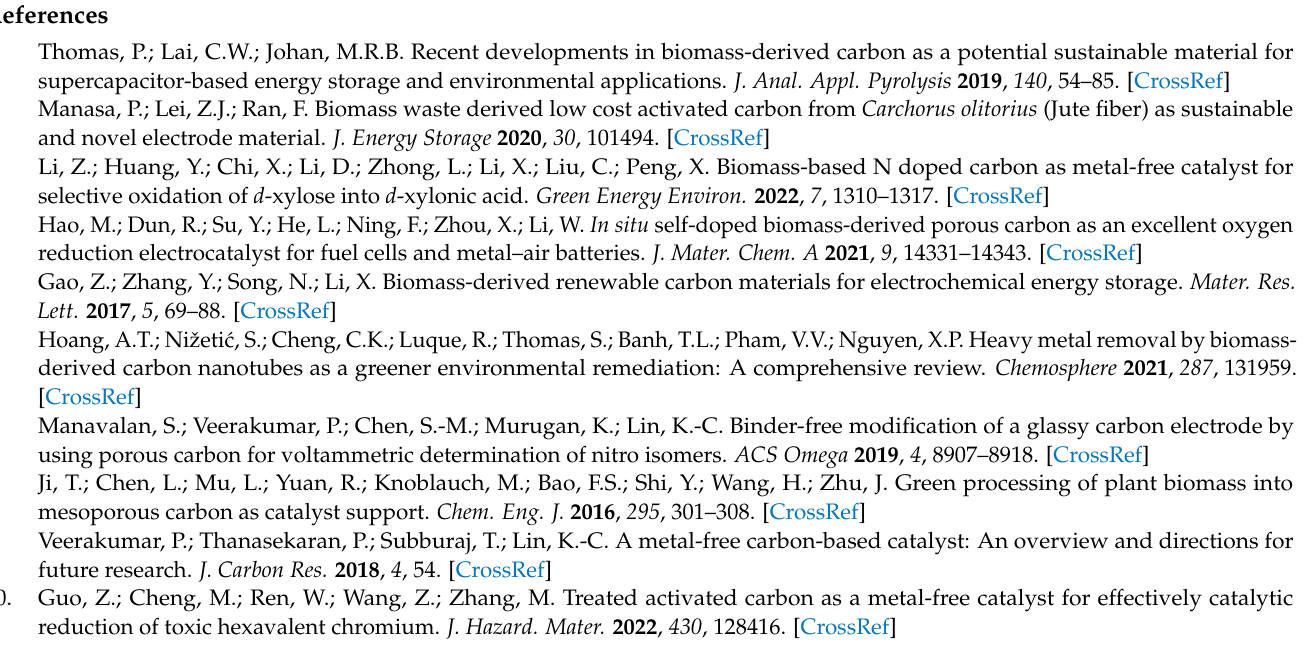
Figure S2: FT-IR spectrum of dry dragon fruit peels; Figure S3: (a) The FE-TEM dark image indicating the EDS line scan position and (b) the spectrum of a representative elements; Figure S4: (a) STEM image, (b–f) element mapping (N, B, P, C, and O elements), and (g) EDS results of NBP-PC-Mg sample.; Figure S5: (a) STEM image, (b–f) element mapping (N, B, P, C, and O elements), and (g) EDS results of NBP-PC-Fe sample; Figure S6: (a) Absence of NBP-PC-Zn catalyst, (b) presence of 0.2 mg, (c) presence of 0.4 mg of NBP-PC-Zn catalyst, and (b) the corresponding plot of ln(At/A0) vs. time; Figure S7: (a) The kapp for MB reduction of over different dosage of NBP-PC-Zn catalyst and (b) Kinetic curves of MB reduction expressed in the graph ln(At/A0) vs. time (Insert: ln(k) vs. 1/T; Table S1. Chemical and physical characteristics of the organic dyes; Table S2. Summary of XPS data obtained from fitting calculations for the B.E values of each component and their respective